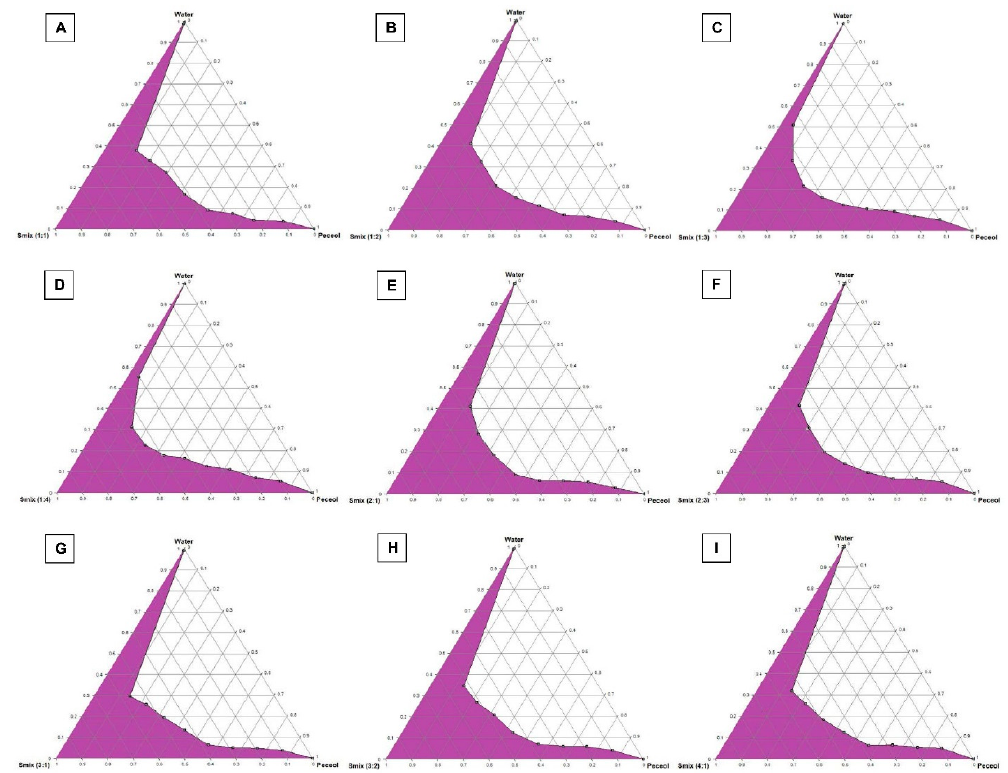
Figure 2. Pseudo-ternary phase diagrams of Peceol, Kolliphor EL, and Transcutol at Smix ratios ( A ) 1:1,